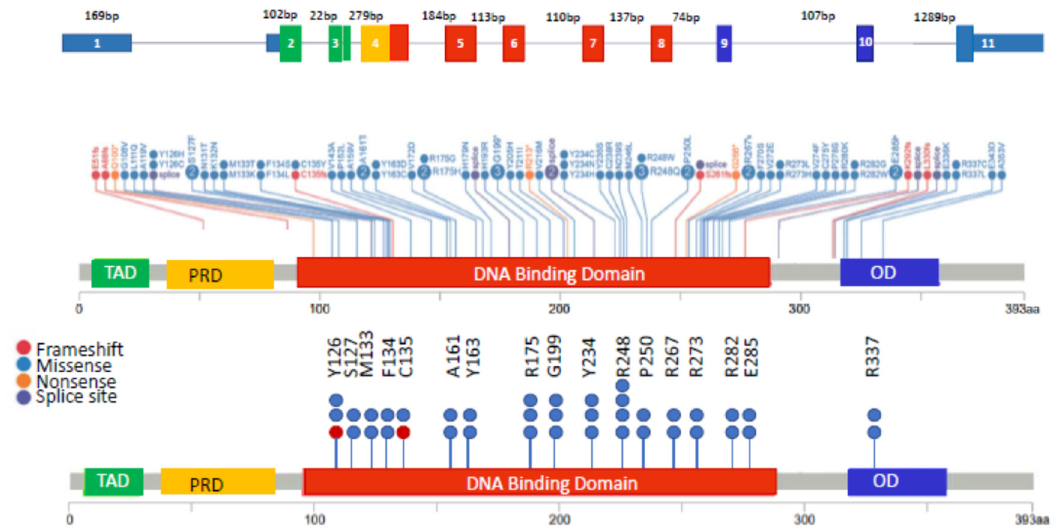
Figure 3. TP53 mutation spectrum in MM: Top: Structure of TP53 gene with numbered exons, colors correspond to domains highlighted in middle and bottom panels. Middle: TP53 mutations in MM by type and location within the gene. Bottom: Hotspot mutations in TP53 in MM. Only mutation sites that were detected in ≥ 2 patients in the MGP dataset ( n = 863) are shown. Each circle represents one patient with blue representing missense mutations, purple representing splice site mutations, red representing frameshifts, and orange representing nonsense mutations. TAD = Transactivation domain TAD (green), PRD = proline rich domain (yellow), OD = oligomerization domain (blue).